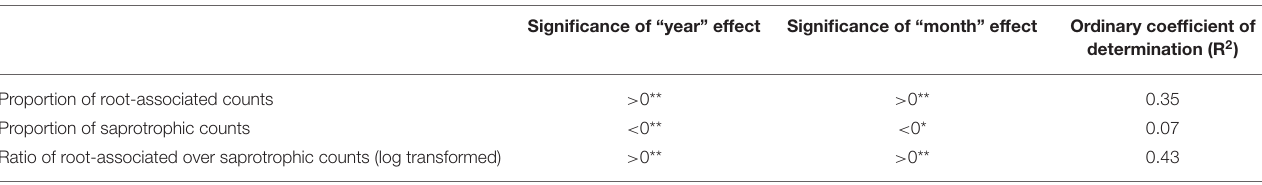
TABLE 2 | Summary of results from linear mixed effect models to predict root-associated and saprotrophic contributions to the total sequence counts, and the ratio of root-associated over saprotrophic counts. Significance of “year”